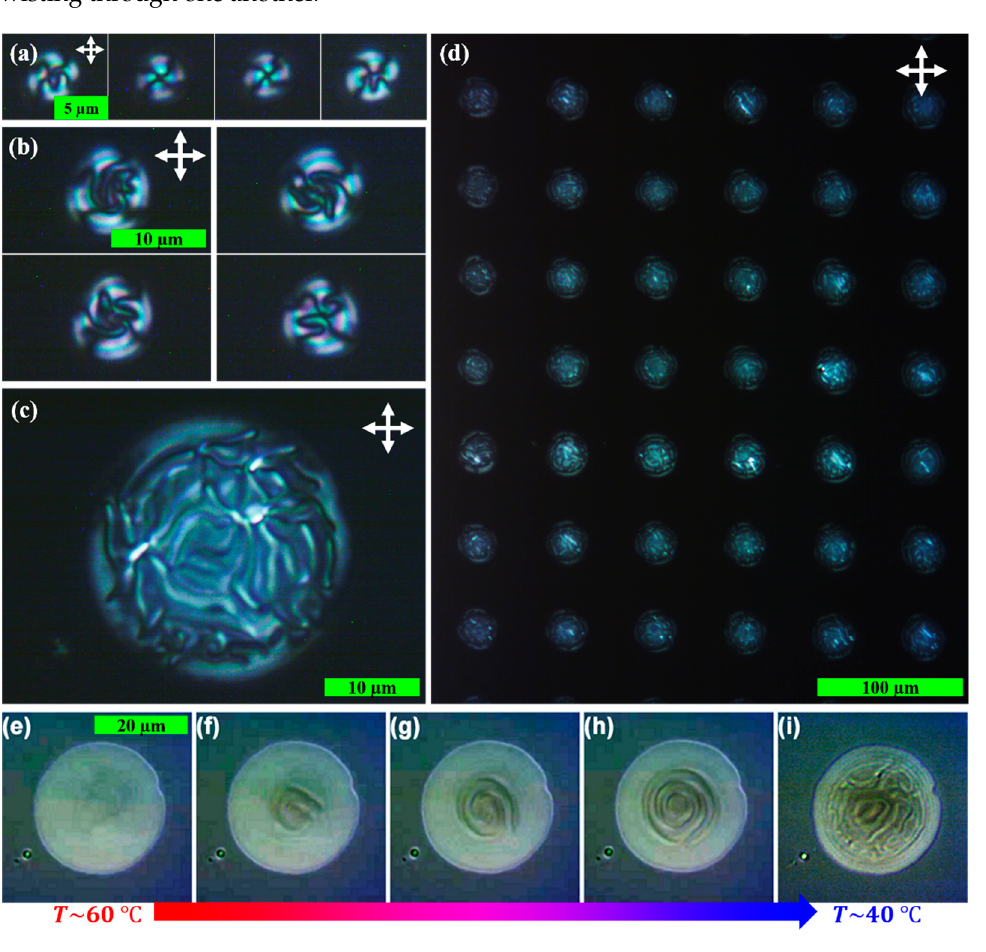
Figure 4. Self-localized cholesteric droplets. Characteristic images of ( a ) 10 µ m ( b ) 12.5 µ m, and ( c ) 30 µ m droplets. ( d ) Array of 30 µ m cholesteric droplets. ( e – i ) 30 µ m droplet of a cholesteric LC with decreasing temperature.